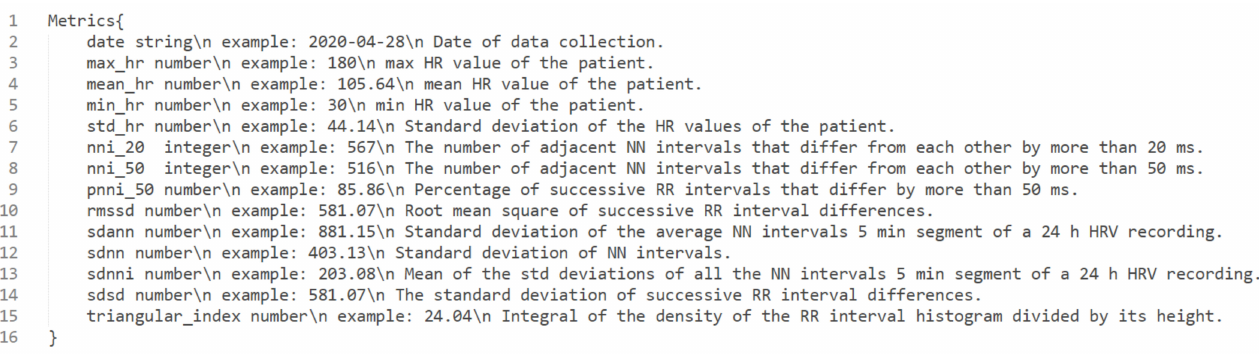
Figure 5. Metrics data model for